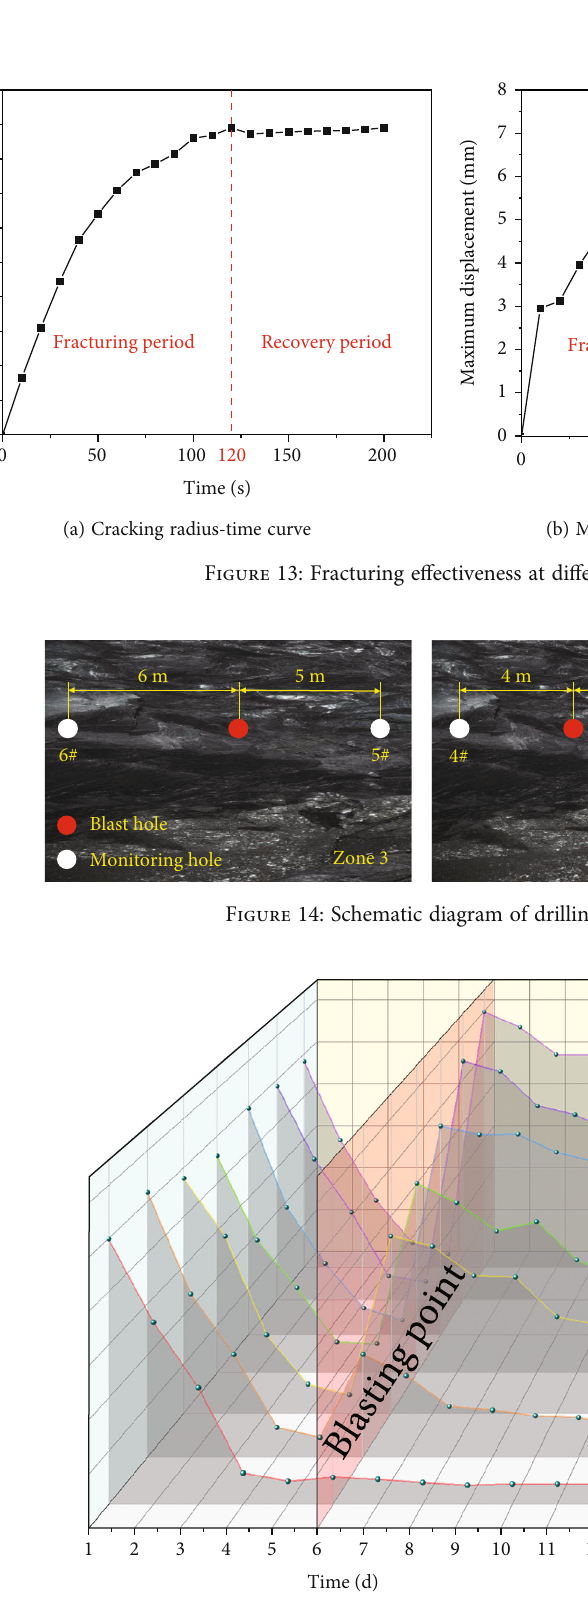
Figure 15: Methane fl ow of boreholes before and after